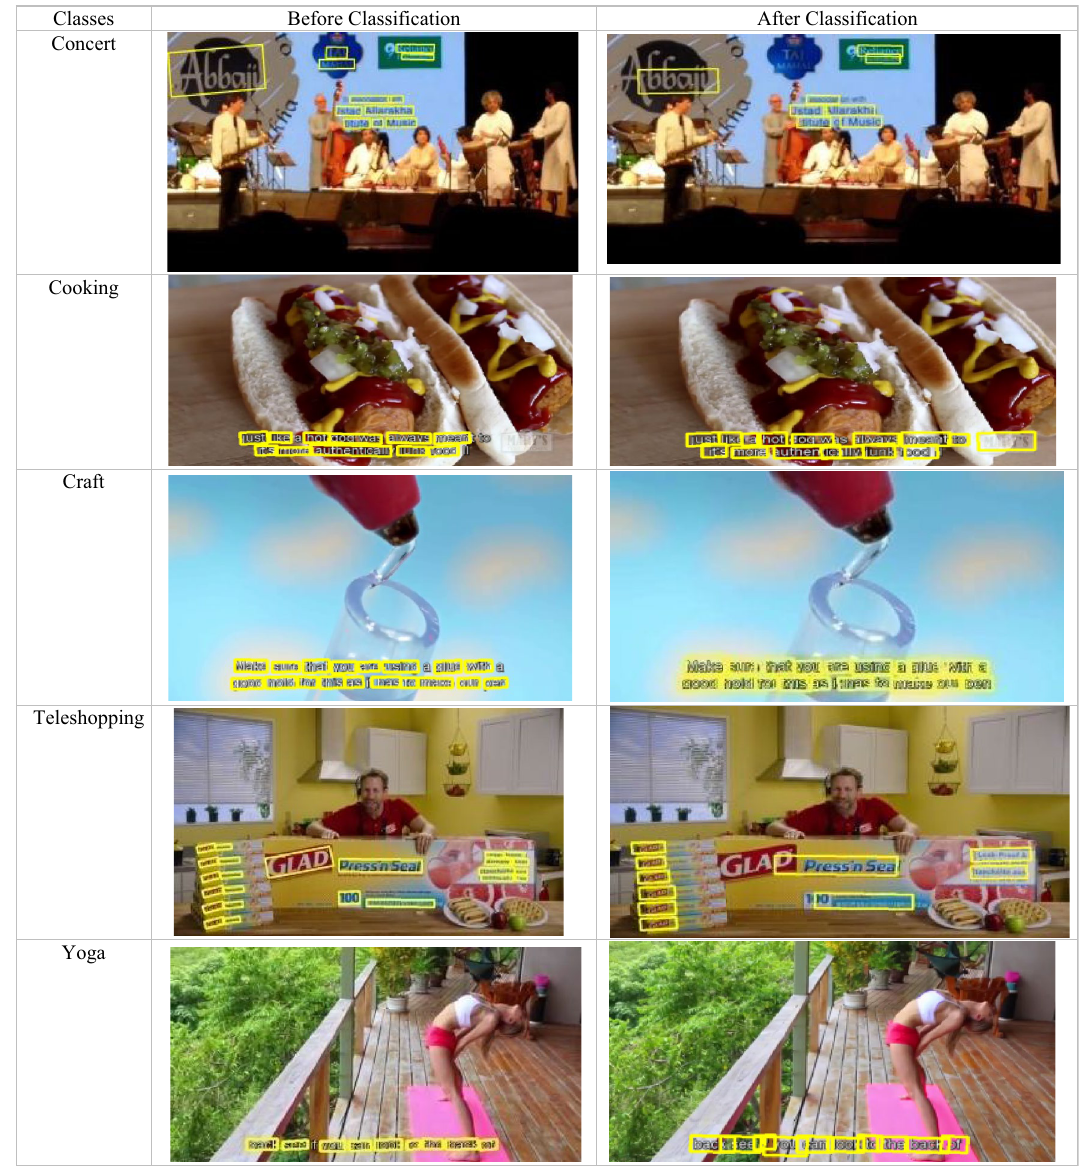
Fig. 9 Sample results of the text detection [9] on our dataset before and after classification. Original Source: [8,